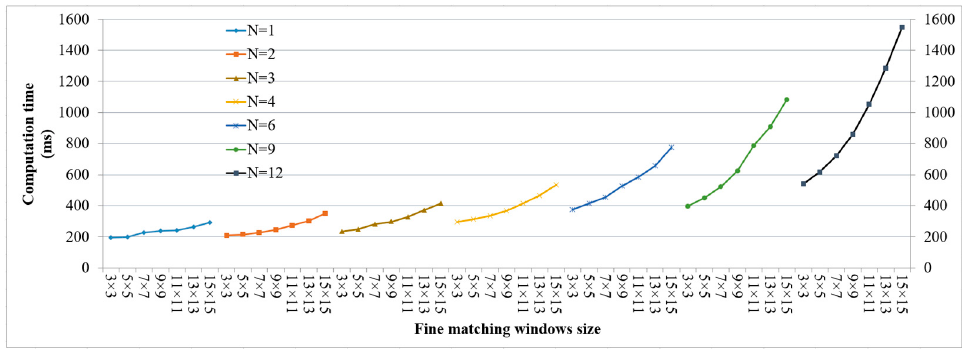
Figure 13. Curves of computation time corresponding to the change of fine window size for different N.